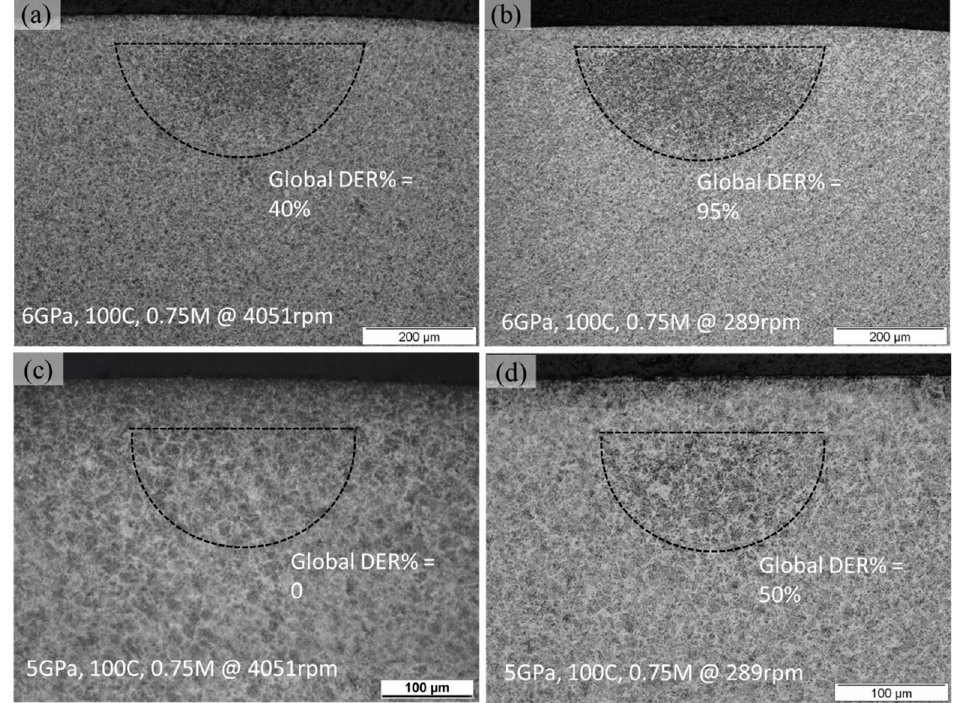
Figure 7. Axially sliced micrographs acquired at 6 and 5 GPa, 100 °C till 0.75 million cycles with ( a , c ) 4051 rpm ( b , d ) 289 rpm speed, respectively. ( a , c ) 4051 rpm ( b , d ) 289 rpm speed,